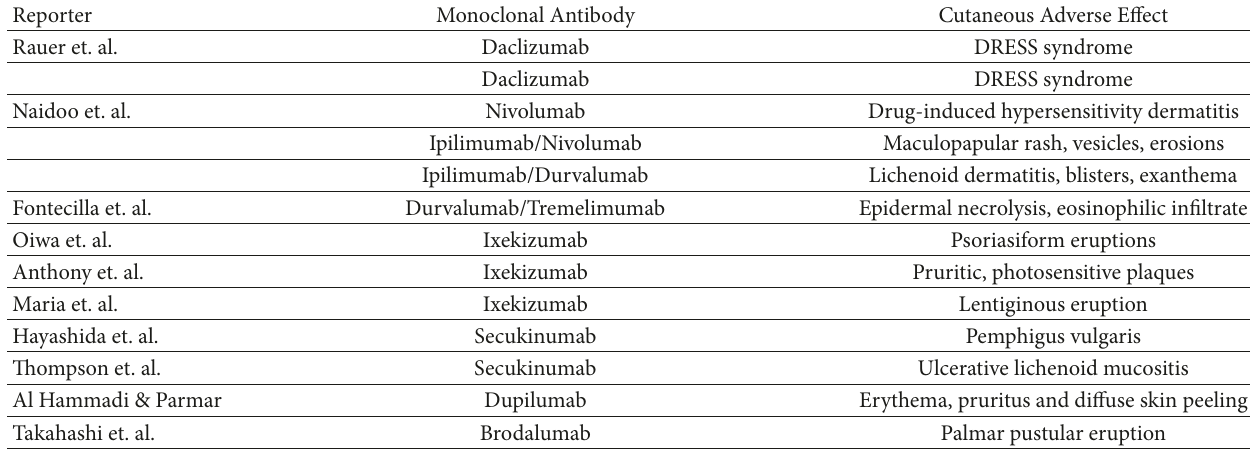
Table 1: Full results of the case study screen organized by reporter and monoclonal